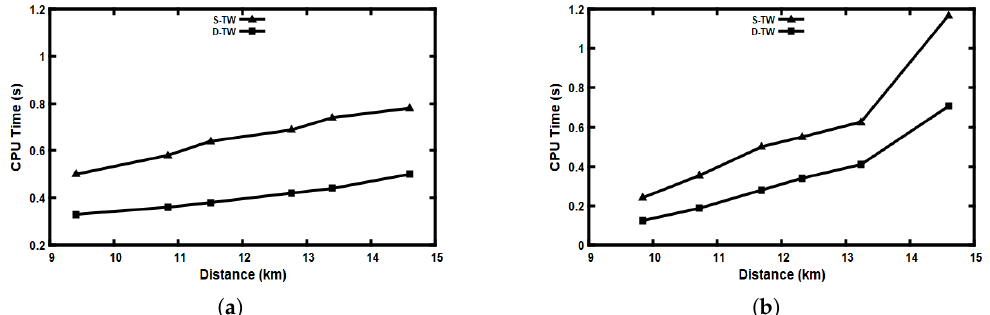
Figure 12. Comparison between CPU time of S-TW and D-TW using different distances: ( a ) outlier threshold ( θ ) = 1 m; ( b ) outlier threshold ( θ ) = 3